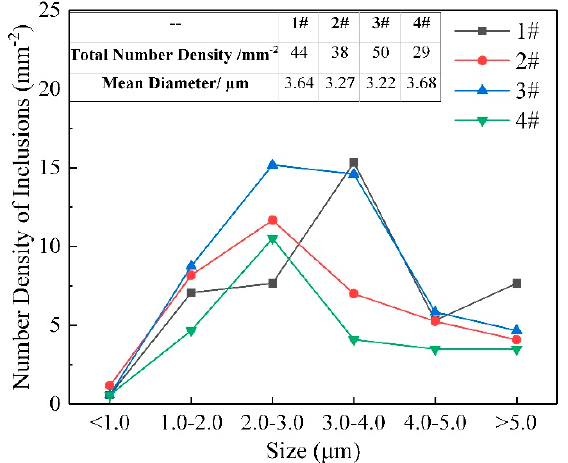
Figure 11. Size distribution of effective inclusions in the as-cast Steel #1 (Ce-free); #2 (0.014% Ce); #3 (0.024% Ce) and #4 (0.037% Ce).